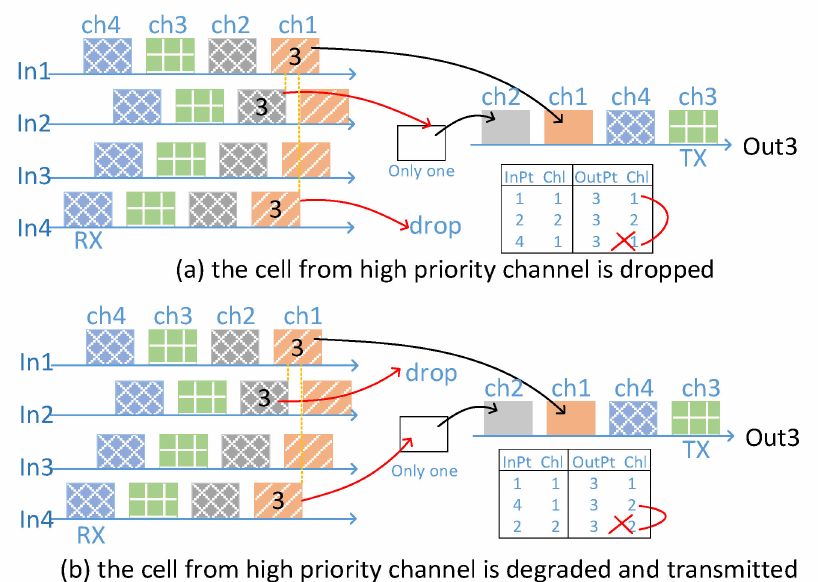
Figure 7. An example of virtual channel